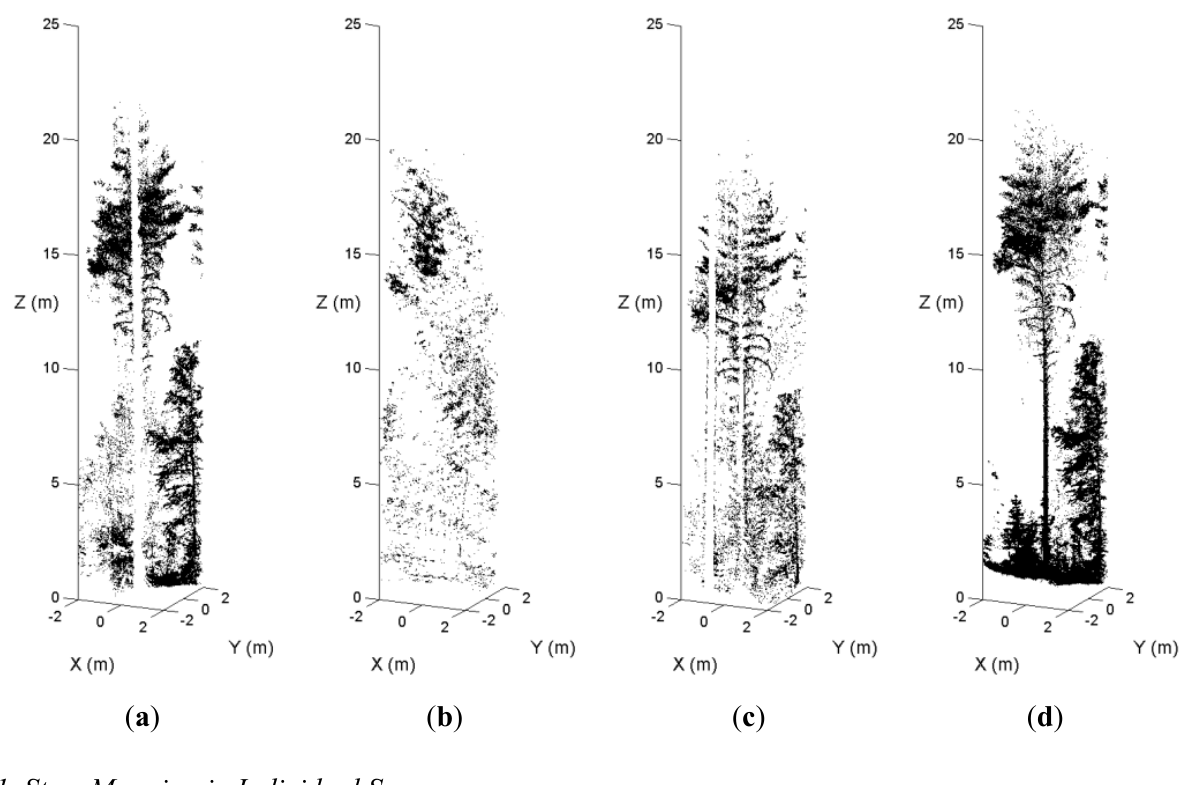
Figure 5. An example of the occlusion effect on a sample plot. The point clouds of a pine tree from the center scan and three border scans are shown in ( a ), ( b ), ( c ), and ( d